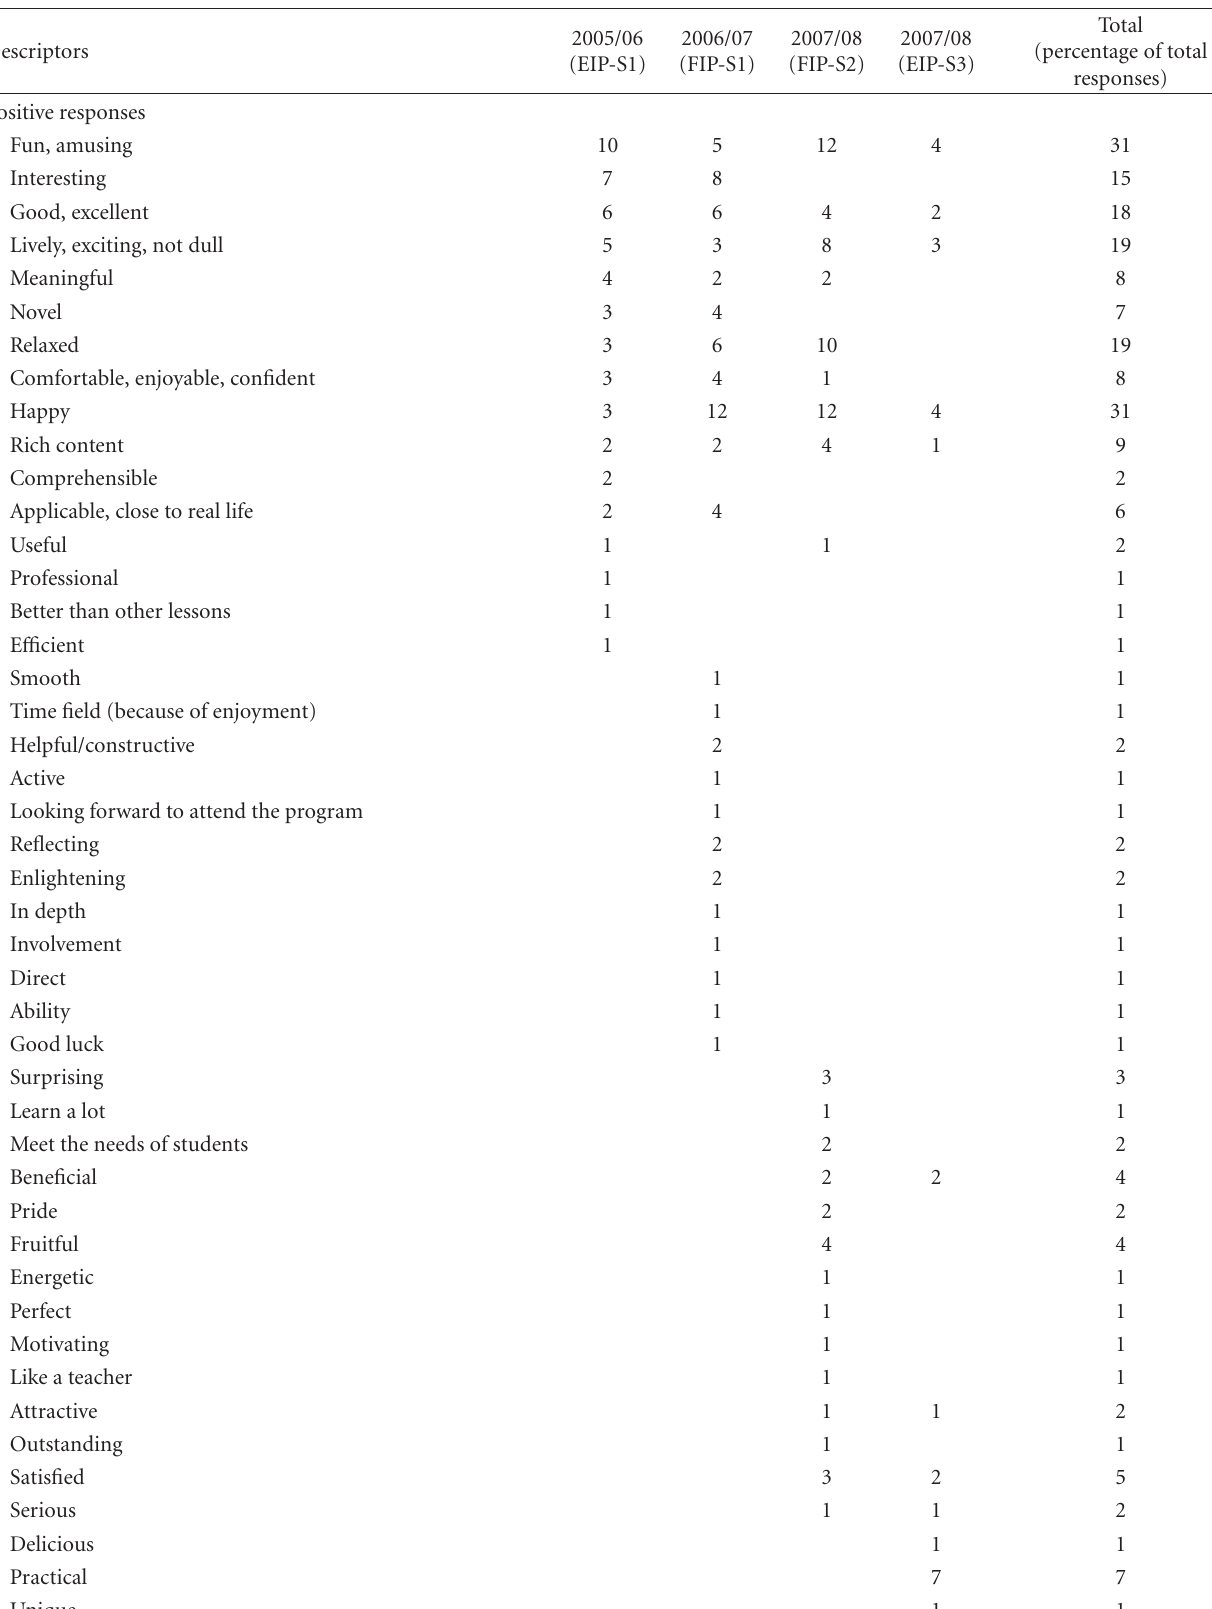
Table 3: Categorization of the descriptors used by the students to describe the